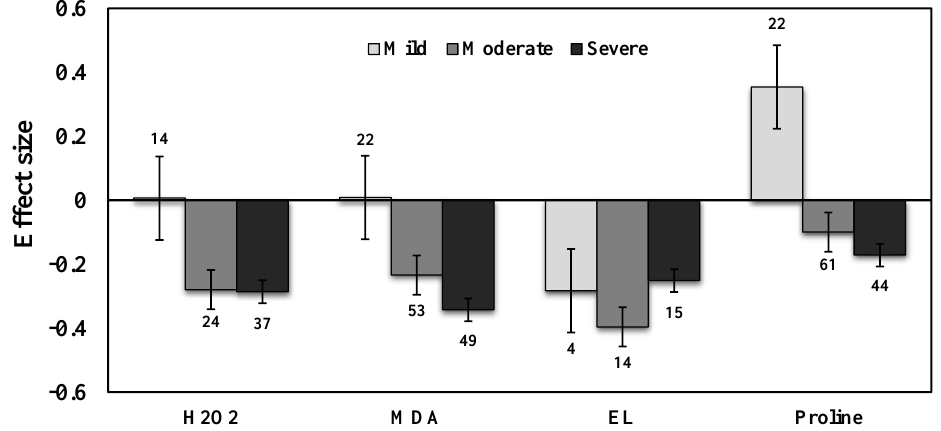
Figure 3. Effect of drought stress on H 2 O 2 , MDA, EL, and Proline levels in AMF inoculated plants. Error bars are means ± 95% confidence intervals (CIs). Where the CIs do not overlap the horizontal lines, the effect size for a response variable is significant at p < 0.05. The numbers of observations are shown above the bar. Note: H 2 O 2 − Hydrogen peroxide, MDA − Malondialdehyde, EL − Electrolyte leakage.